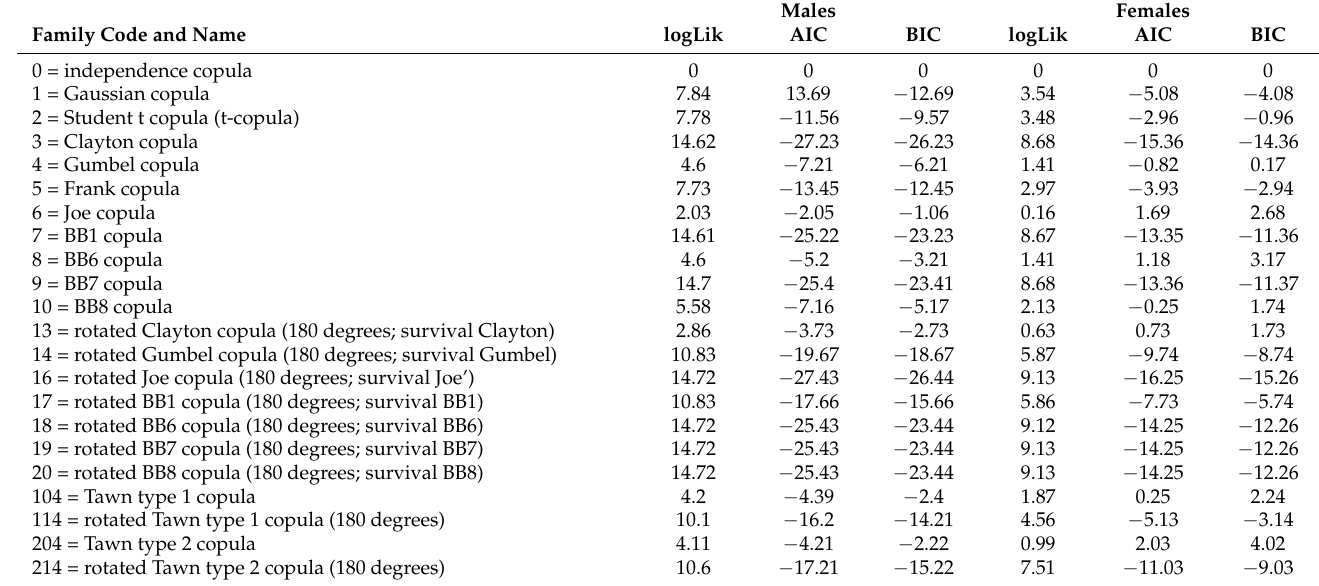
Table 3. Model selection results for males and females.